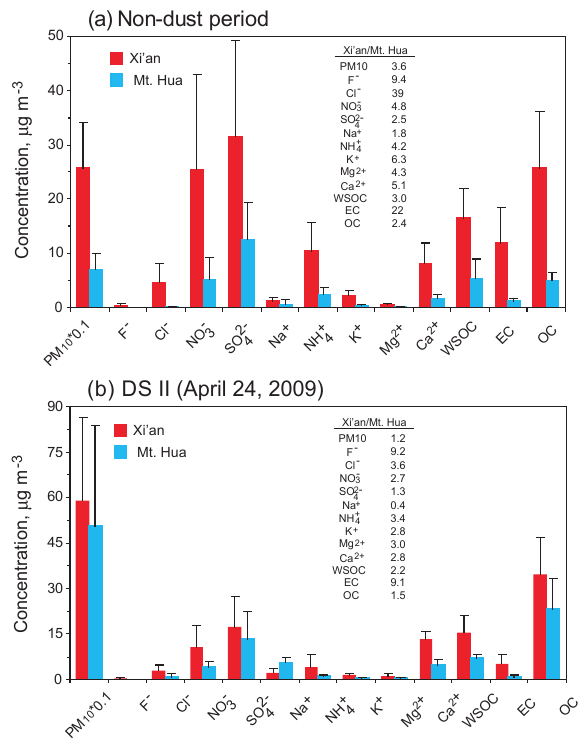
Fig. 6. Differences in concentrations of components of PM 10 from Xi’an and Mt. Hua during the non-dust and dust storm periods (in- serted numbers are the concentration ratios of Xi’an to Mt. Figure 6. Difference in concentration of airborne species in Xi’an and Mt. Hua during the non-dust and dust storm periods (inserted numbers are the concentration ratios of Xi’an to Mt. Hua)